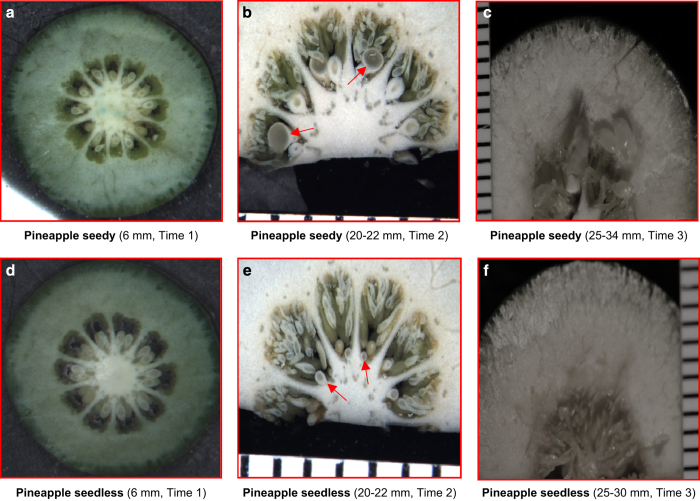
Seed development in seedy and seedless Pineapple sweet orange at 9 days (a and d), 26 days (b and e) and 50 days (c and f) post anthesis. The distance between black lines in rulers of (b, c, e and f) was 1 mm and the sizes of fruits at each time point are shown under each panel. The red arrows in (b) indicate the developing seeds and the red arrows in (e) indicate the aborted seeds.